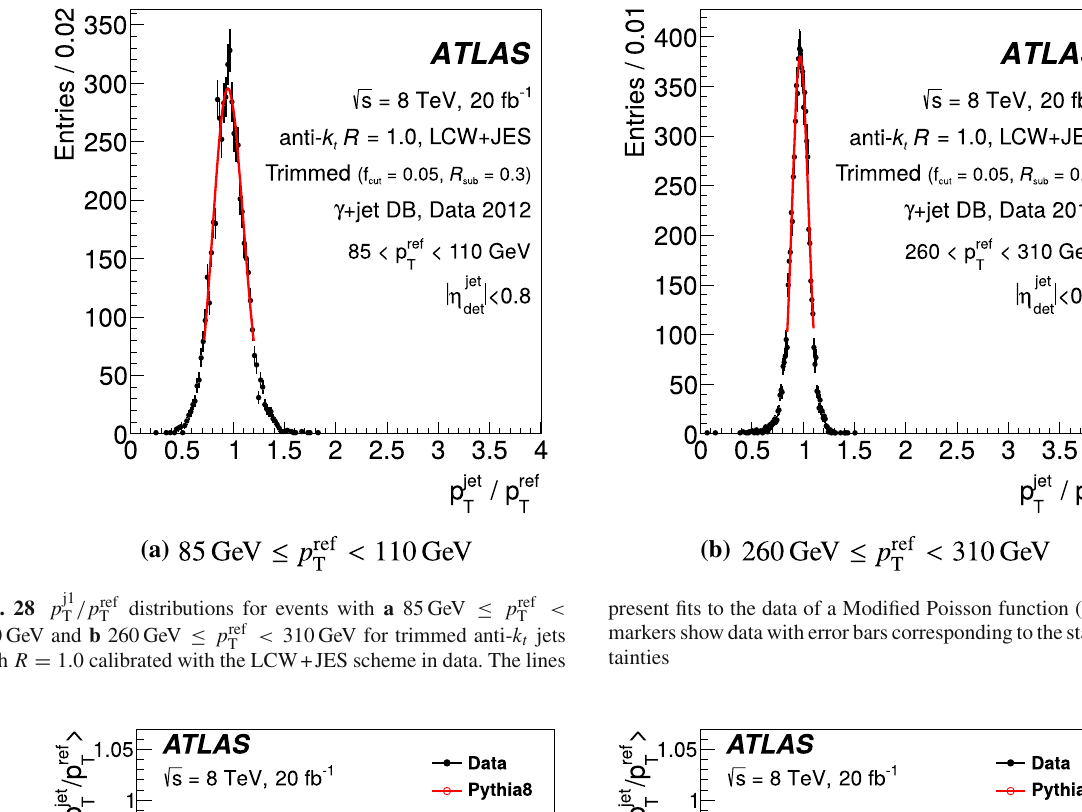
. Only statistical uncertainties are T